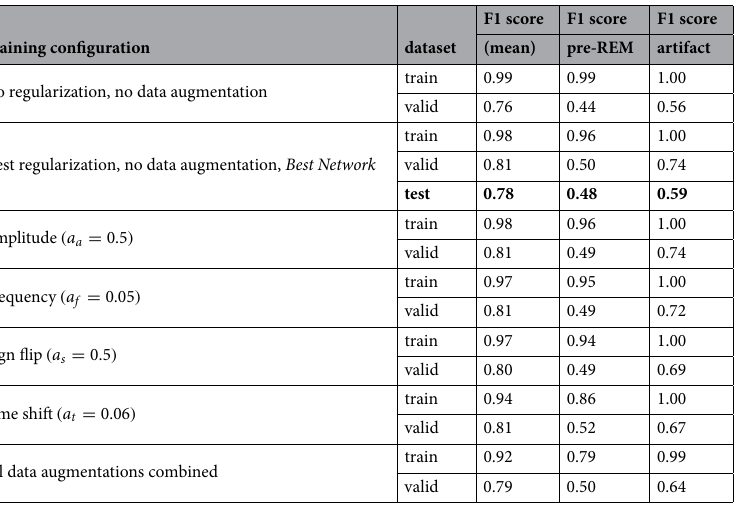
Table 3. F1 scores for the training, validation, and test set at various training configurations. First, the network was trained without L2 regularization and without dropout (row 1). Next, the network was trained with both regularizations (row 2). Last, the network was trained using different types of data augmentation (rows 3–6; the parameters in column 1 resulted in the best validation F1 scores among the explored parameters), or with all data augmentations combined (row 7). F1 scores averaged over all classes (column 3) characterize how well the networks can predict sleep stages on all five classes. F1 scores in columns 4 and 5 present the capabilities of the networks to predict the two minority classes pre-REM and artifact, respectively. Only the network with the best validation F1 scores (best network) was evaluated on the test